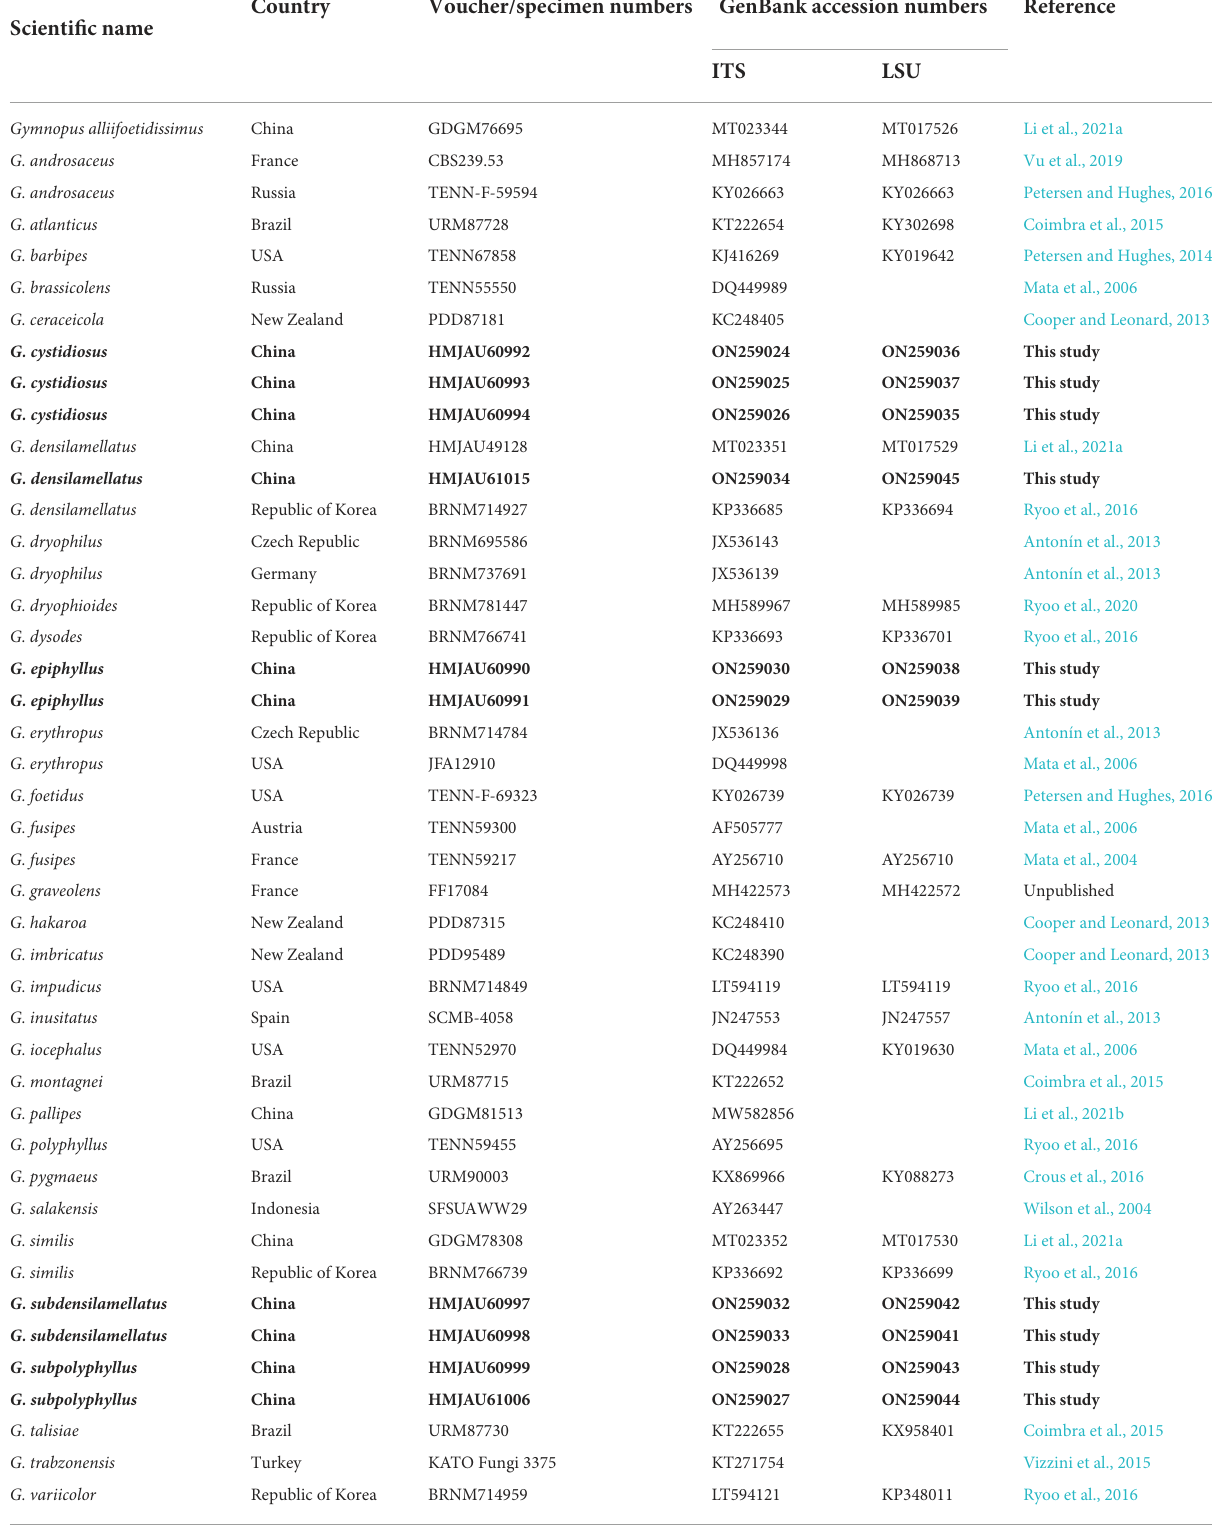
TABLE 1 Voucher/specimen numbers, Country, and GenBank accession numbers for the specimens of Gymnopus and related genera used in the study; sequences produced in this study are